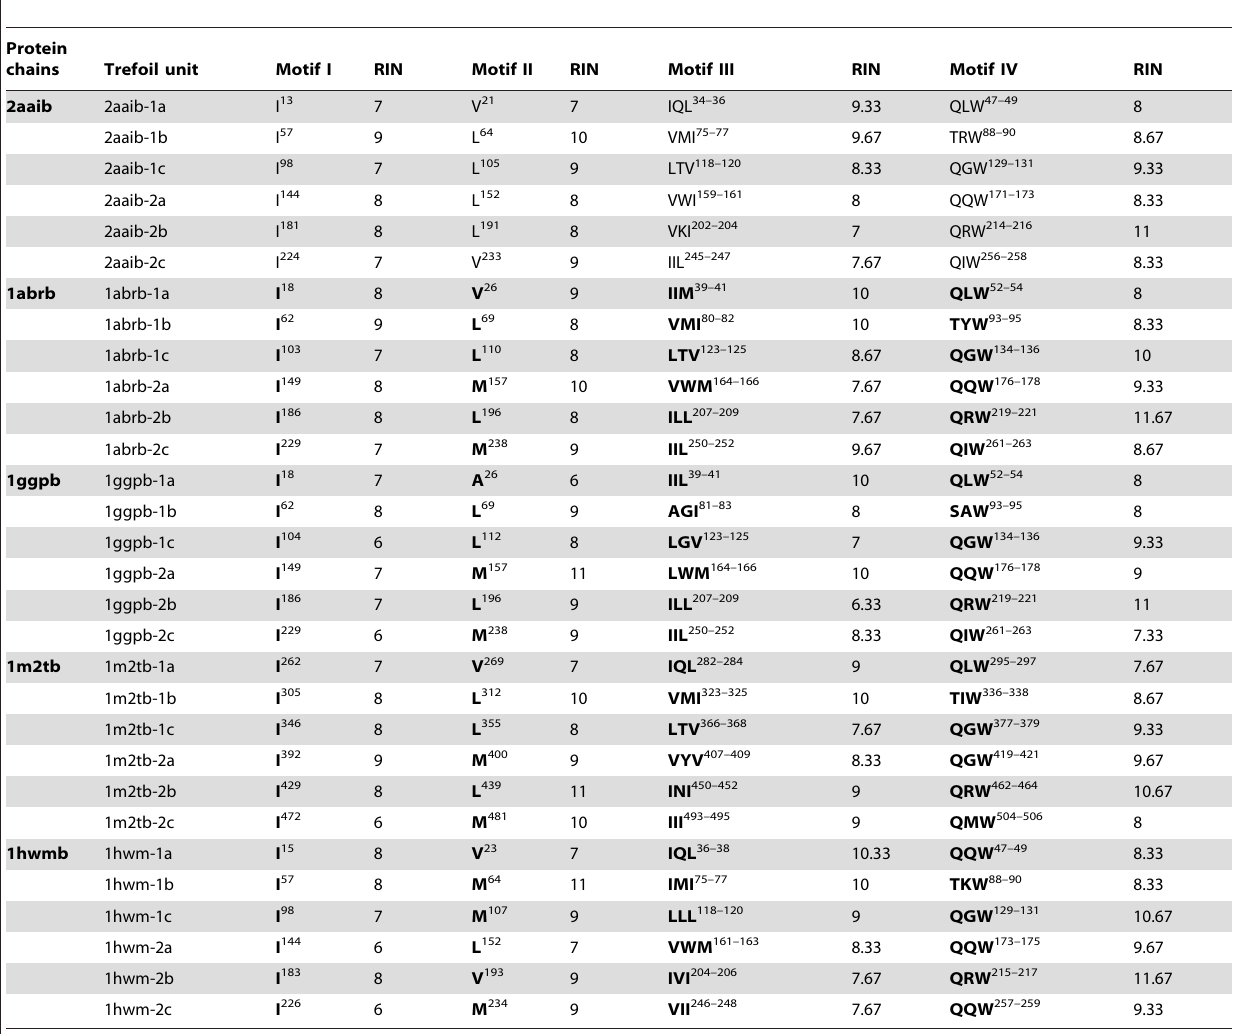
Table 4. The averaged residue interaction numbers (RINs) for FTR motifs in five representative protein chains. The superscript numbers are their indices in sequences.